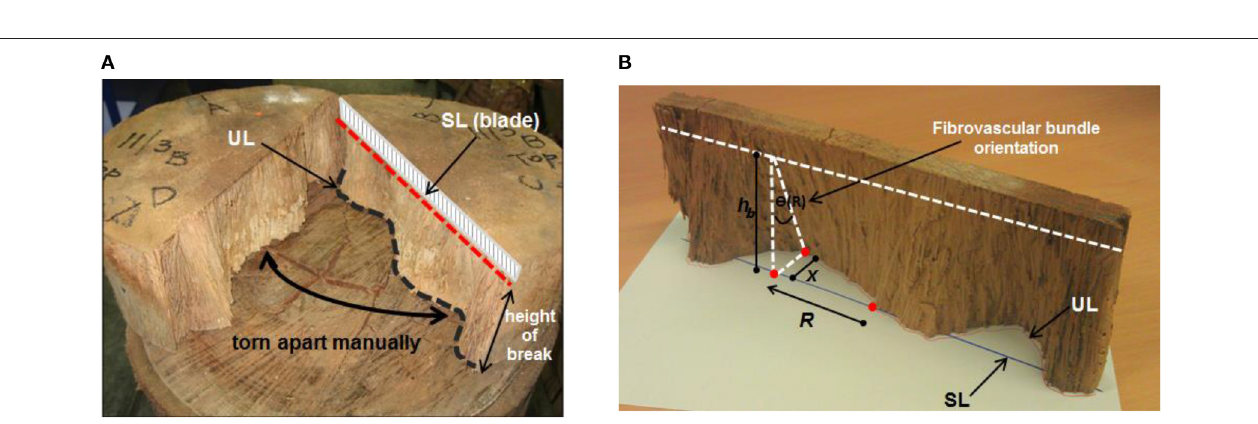
FIGURE 2 | Cocowood triple helix pattern shown in a radially split disc. Similar to the zigzag pattern described by Rüggeberg et al. (2008) for Washingtonia robusta palms, the cocowood fibrovascular bundle architecture follows an axisymmetric and triple helix configurations across the palm stem diameter.